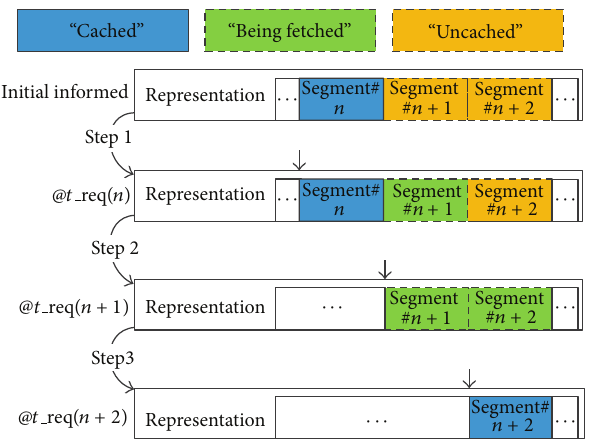
Figure 3: Example of estimating each segment caching status when the segment is to be